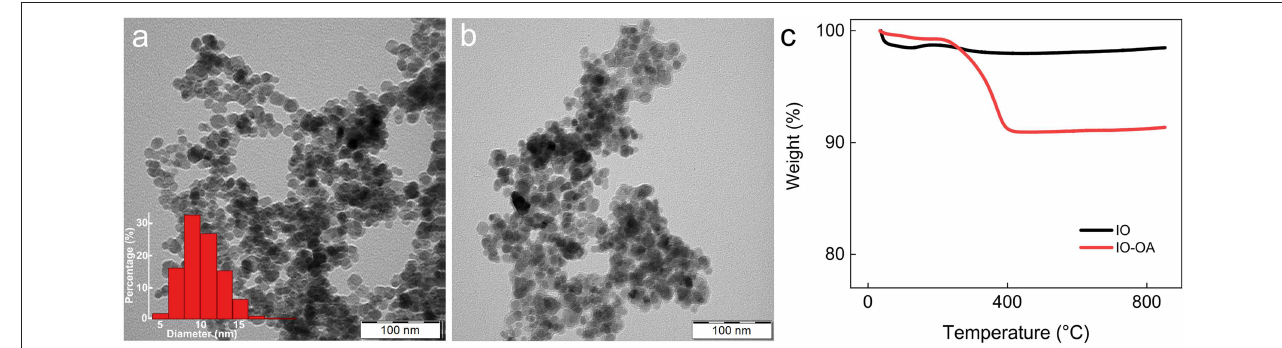
FIGURE 1 | TEM micrographs of (a) IO (particle size distribution inserted) and (b) IO-OA nanoparticles. (c) Thermogravimetric analysis of IO and IO-OA nanoparticles.